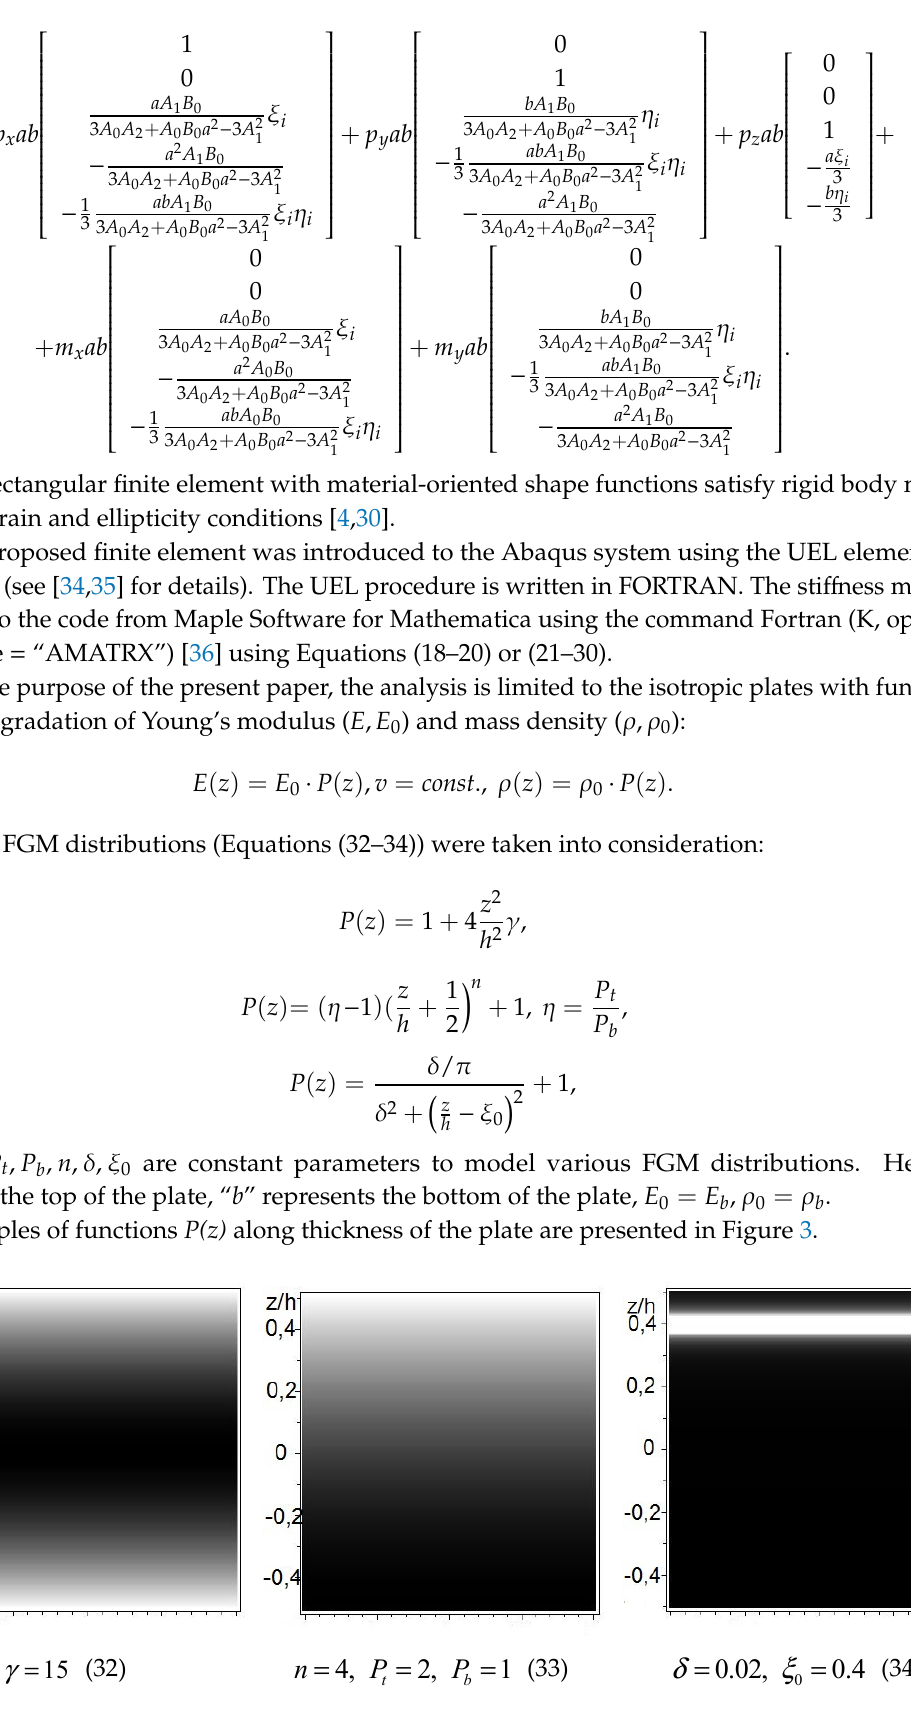
Figure 3. Selected transverse nonhomogeneous materials of the plate.